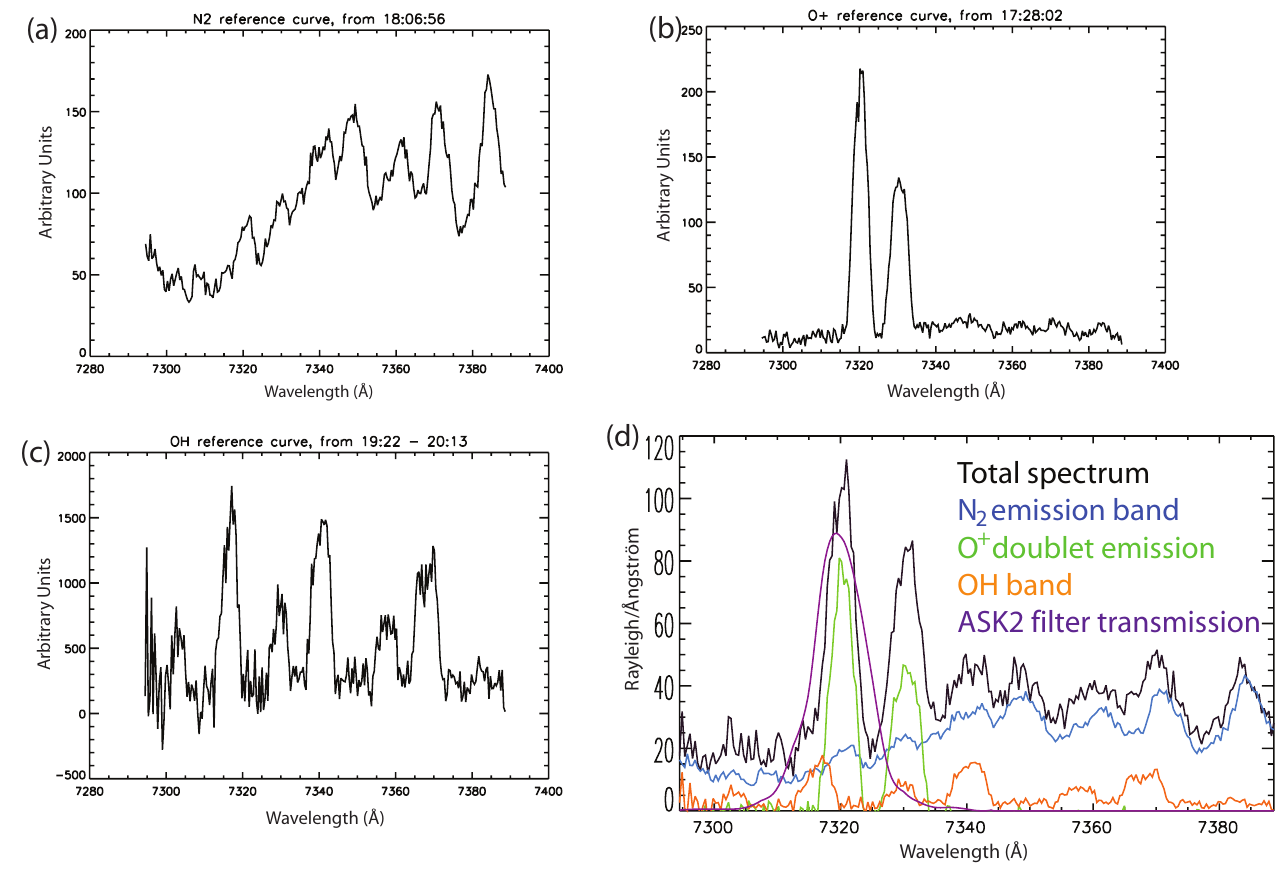
Fig. 1. Reference spectra for (a) N 2 1PG band, (b) O + and (c) OH band, obtained from SIF data, at times when only one emission dominates the total spectra. By weighting the reference spectra it is possible to determine how much each emission contributes to the resultant spectrum. (d) shows the weighted reference spectra and the resultant spectrum (black) for the time